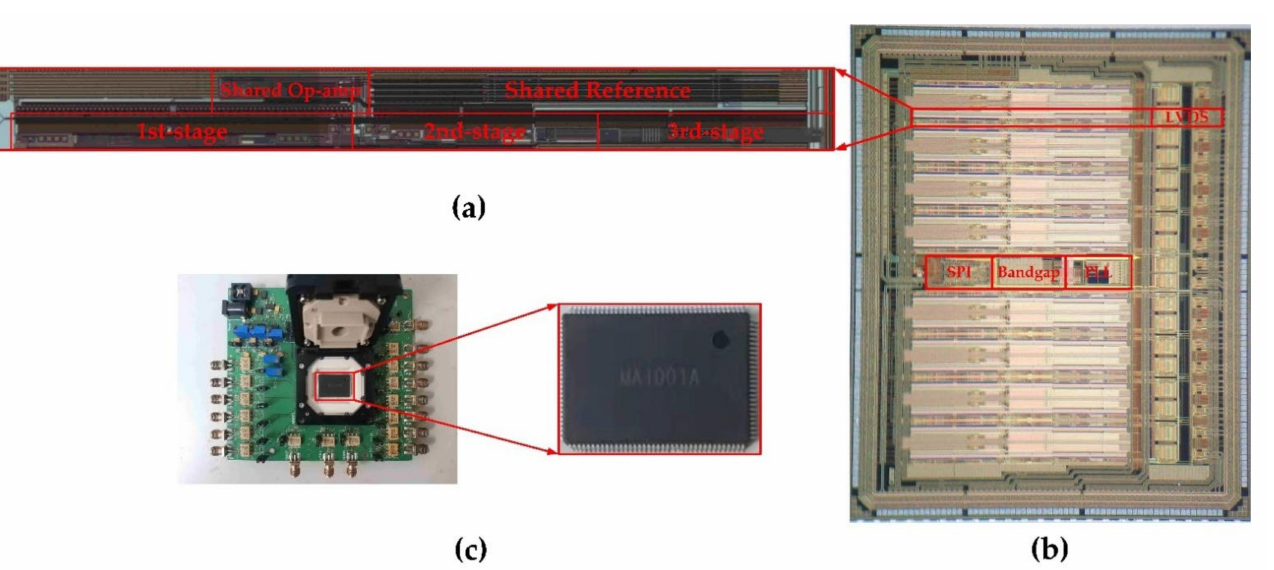
Figure 13. Measured ( a ) DNL error and ( b ) INL error. The DNL error and INL error is − 0.46/0.6 LSB and − 2.53/1.32 LSB, respectively. They are calculated from a histogram test with full-swing input and 16,384 sampling points. Figure 12. Photograph of ( a ) single-channel ADC, with main blocks marked in the red box; ( b ) 16-channel ADC with peripheral circuits integrated, which are also annotated; and ( c ) package and the batch test board with a socket.